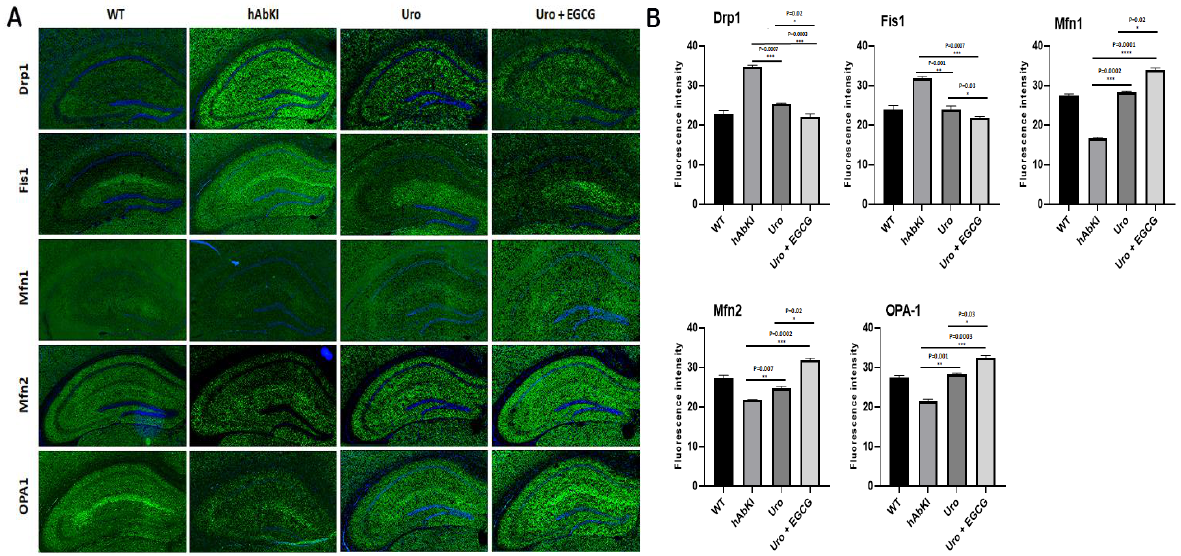
Figure 8. Immunofluorescence analysis of hippocampal mitochondrial fission and mitochondrial dynamic proteins in seven-month-old hAbKI mice and treated hAbKI mice with Urolithin A and EGCG. ( A ) Immunofluorescence staining and quantitative immunofluorescence analysis of hAbKI mice treated hAbKI mice with Urolithin A and EGCG. ( B ) Drp1 and Fis1 levels were significantly decreased in the treated hAbKI mice with Urolithin A and EGCG.